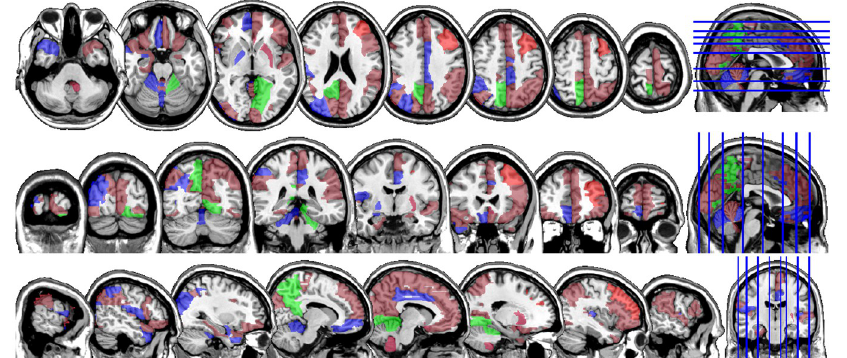
Fig 5. The multi-slice display (Axial, Coronal, Sagittal) of the regions of interests, the BOLD activities of which achieves the lowest prediction error and correlate the most with the ADHD score variability in the sample when the MFG-LASSO is used. The regions associated with the ADHD score are colored red, those associated with the ADHD Hyper/Impulsive are blue, and the ones associated with the ADHD Inattentive score are colored green.